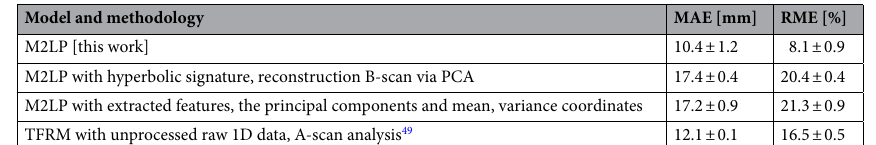
Table 7. Average performance metrics of the proposed and the benchmark cases and standard deviation, computed over ten independent runs.